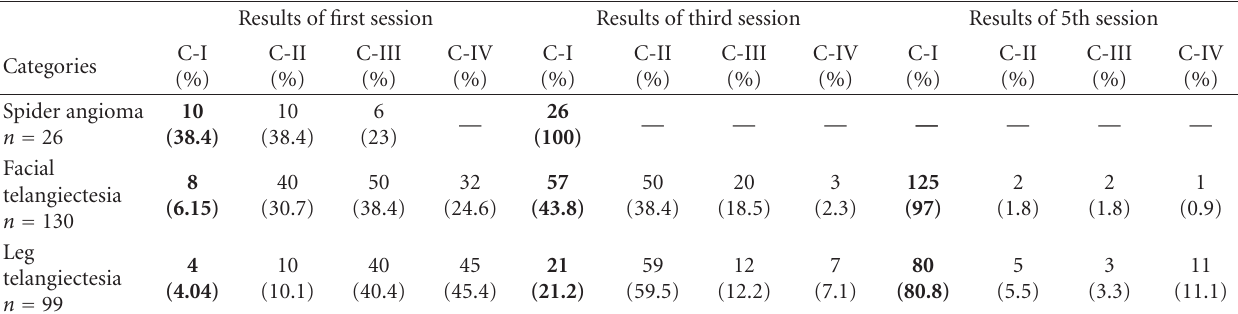
Table 3: E ffi cacy results of patients after laser session according to type of